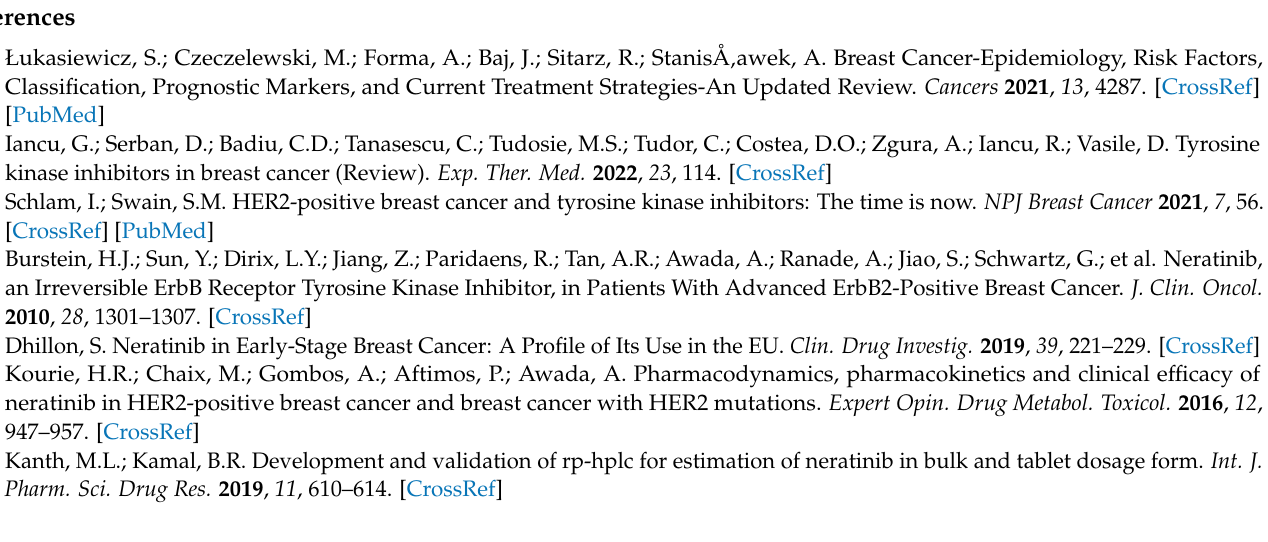
parameter details, Table S2: Details of MS/MS parameters for studied analytes, Table S3: Data showing extraction recovery and matrix effect; Figure S1: Representative MRM chromatograms of blank plasma samples of (A) NER, (B) I.S. and (C) NRN at 80 ng · mL − 1 concentration; Figure S2: Representative MRM chromatograms of plasma samples spiked with (A) NER, (B) IS, and (C) NRN at 80 ng · mL − 1